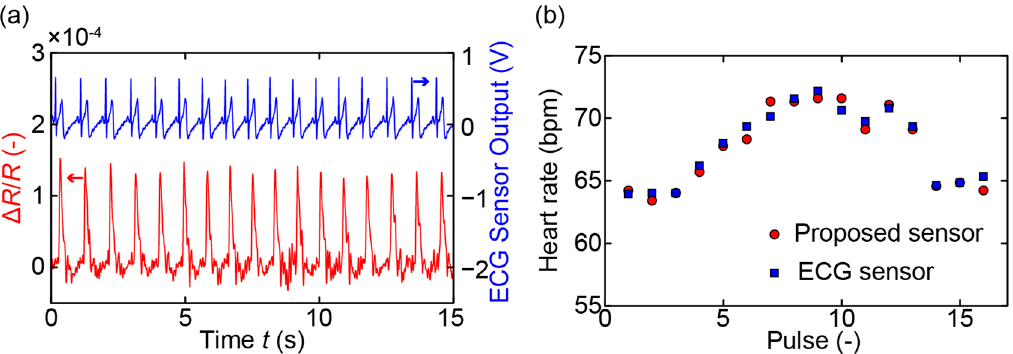
Figure 6. Heart rate measurement. ( a ) The output of the fabricated sensor and the commercial electrocardiogram sensor. ( b ) Heart rates calculated from the outputs of the fabricated sensor and the ECG sensor.